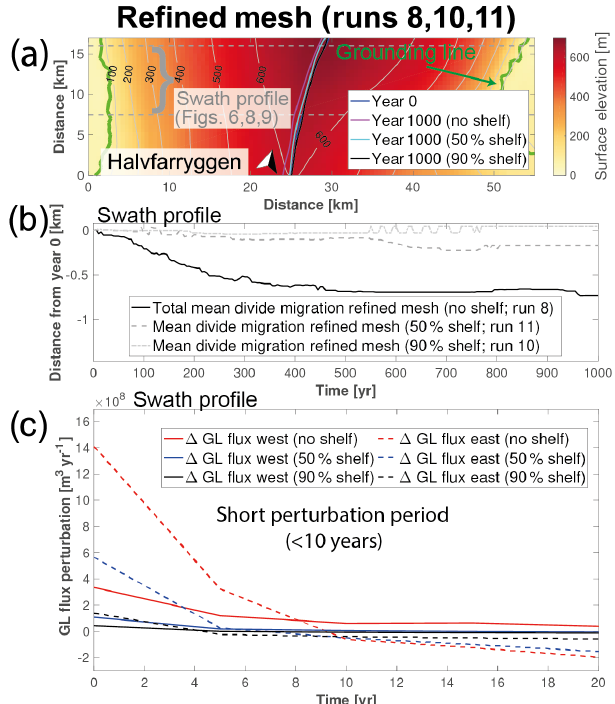
Figure 9. ( a – c ) Ice-rise divide migration for the Halvfarryggen Ice Rise induced by different ocean perturbations (shelf removal, 50% ice-shelf thickness, and 90% ice-shelf thickness) for the refined mesh. (a) shows divide position at the end of the simulation period. Grey dashed lines show the approximate area used for flux calcula- tions in (c) . (b) shows mean divide migration for the different per- turbations. Negative numbers indicate migration to the west. (c) dis- plays ice flux perturbation across the grounding line for the eastern and western side of the divide for the first two decades. Perturbation fluxes smaller than 0 indicate that ice flux across the grounding line is reduced in comparison to the reference simulation. (b, c) “Swath profile” indicates that computed divide migration is averaged over cross sections as shown in (a) . For the (cid:49) GL flux, this means that the flux is summed along the current grounding-line position over the swath length.